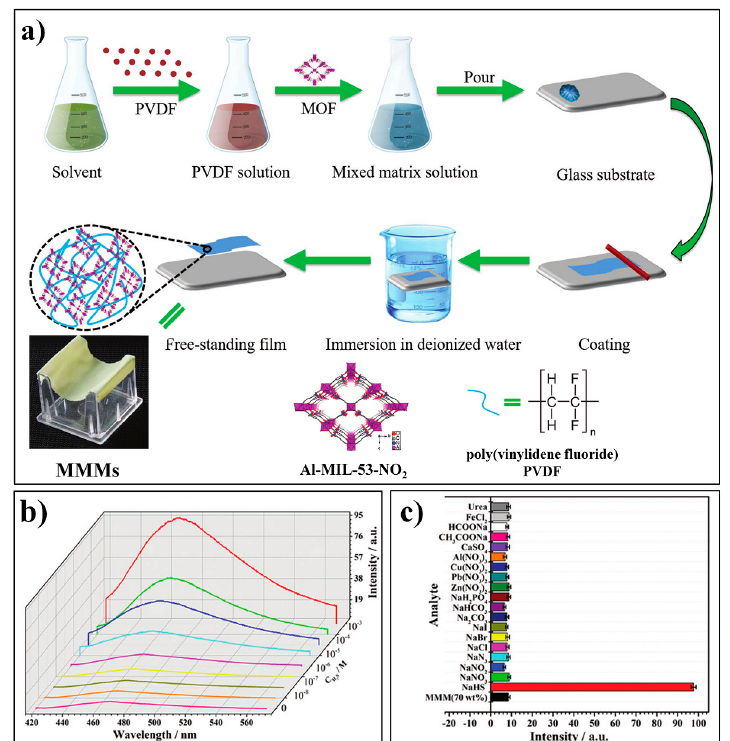
Figure 4. ( a ) Fabrication process for Al-MIL-53-NO 2 @PVDF MOF-polymer mixed-matrix membranes (MMMs). ( b ) Fluorescence spectra of Al-MIL-53-NO 2 @PVDF MMMs (70 wt%) with different concentrations of H 2 S (excited at 396 nm). ( c ) Fluorescence response of Al-MIL-53-NO 2 MMMs at 466 nm toward various analytes. Reproduced with permission from [80]. Copyright